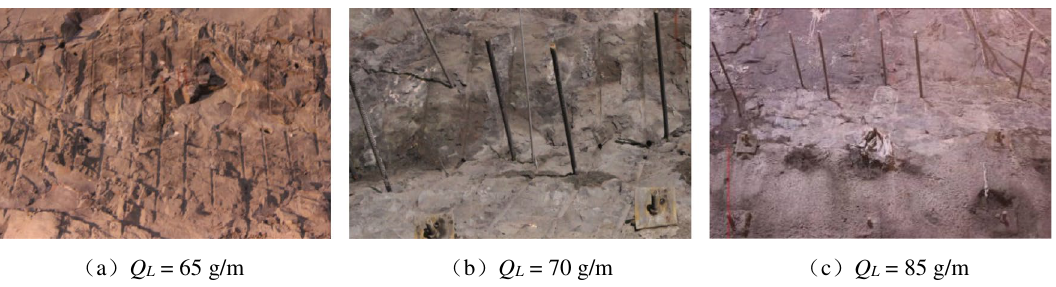
Figure 7. Profile at different linear charging densities by round borehole blasting excavation.